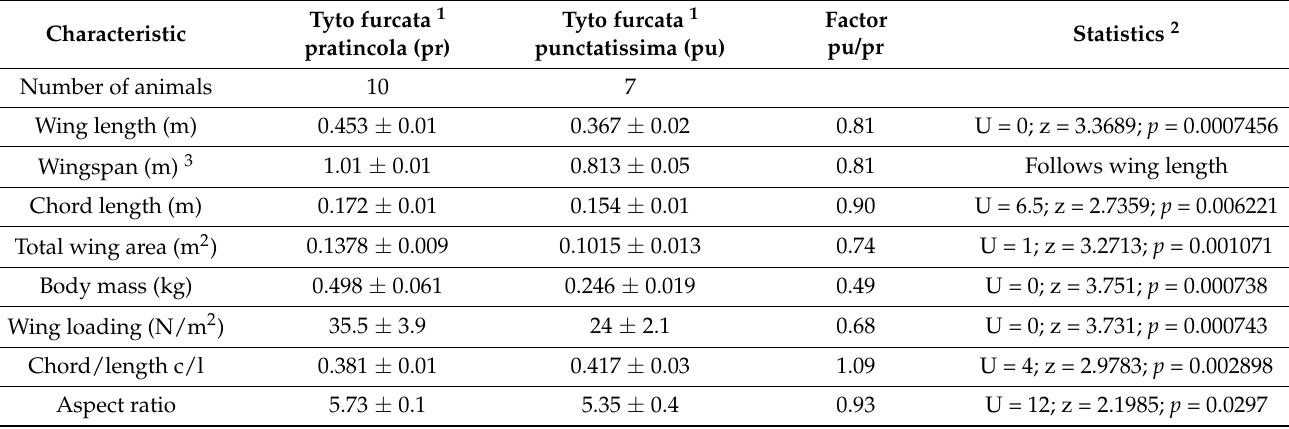
Table 1. Morphometric characteristics of Barn-owl wings: Data of both subspecies.